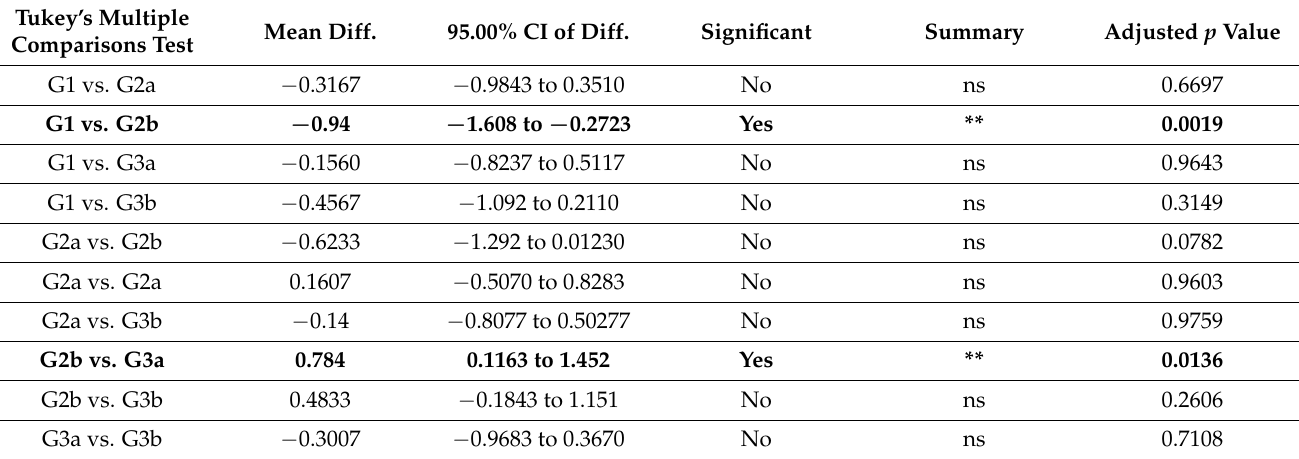
Table 3. TKT 60 M. Tukey multiple comparison test between the groups. Differences were observed for groups G1 vs. G2b (no gingival augmentation vs. CTG before) and for groups G2b vs. G3a (CTG before vs. CMX after). ns, non sugificant; ** for a level of significance.